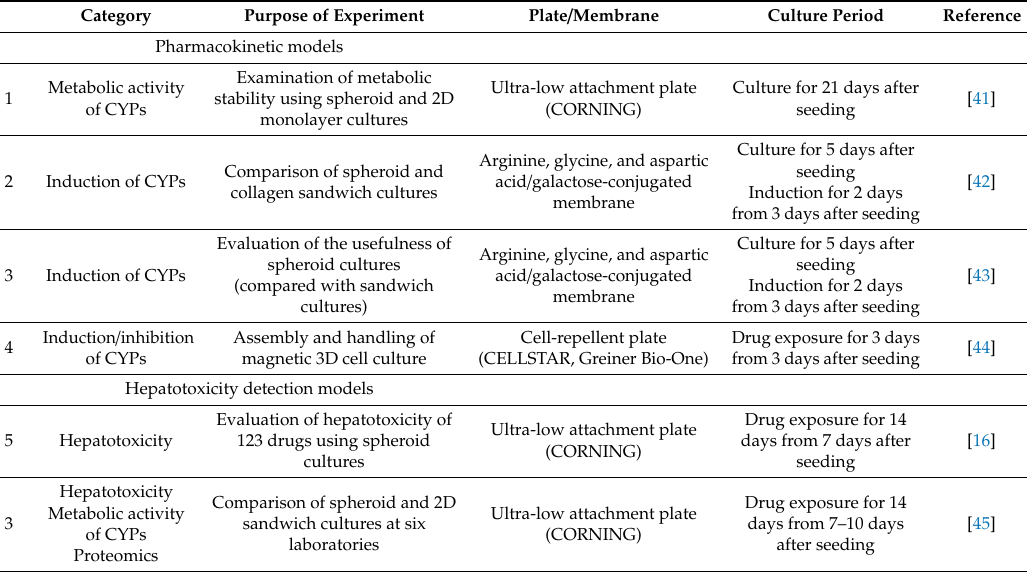
Table 2. Summary of experiments using primary human hepatocyte (PHH) spheroid cultures.